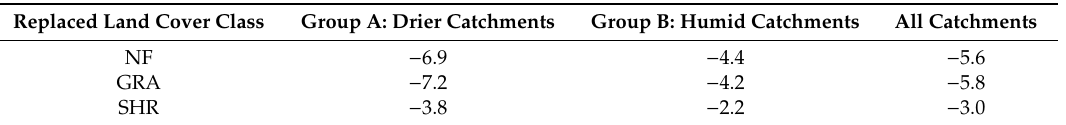
Figure 9. Predicted changes (relative to the annual runoff prediction without land-use-induced land cover change (LULCC)) in annual runoff under scenarios where NF (panels a , b ), GRA (panels c , d ) and SHR (panels e , f ) covers are replaced by patches of FP, for group A and group B catchments, respectively. The map shows the catchments classified as group A (drier) and group B (humid). The color bar represents the catchment area. Areas above 100,000 ha (only two humid basins) are colored in red. Table 1. Predicted water supply change due to the expansion of FP, expressed as percentage of annual runoff change per 10,000 ha of increased FP.